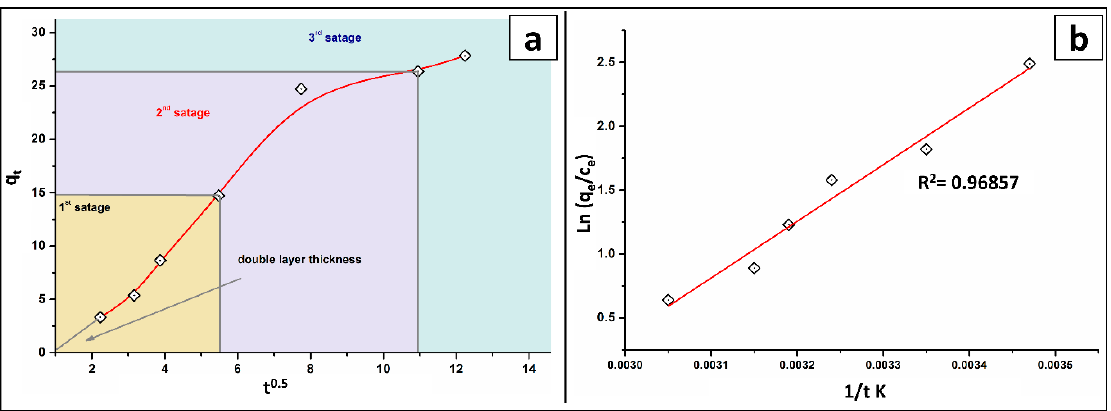
Figure 6. ( a ) Intraparticle-diffusion models and ( b ) the Van’t Hoff plot on the adsorption process of As(V) by BT-An@Zetag